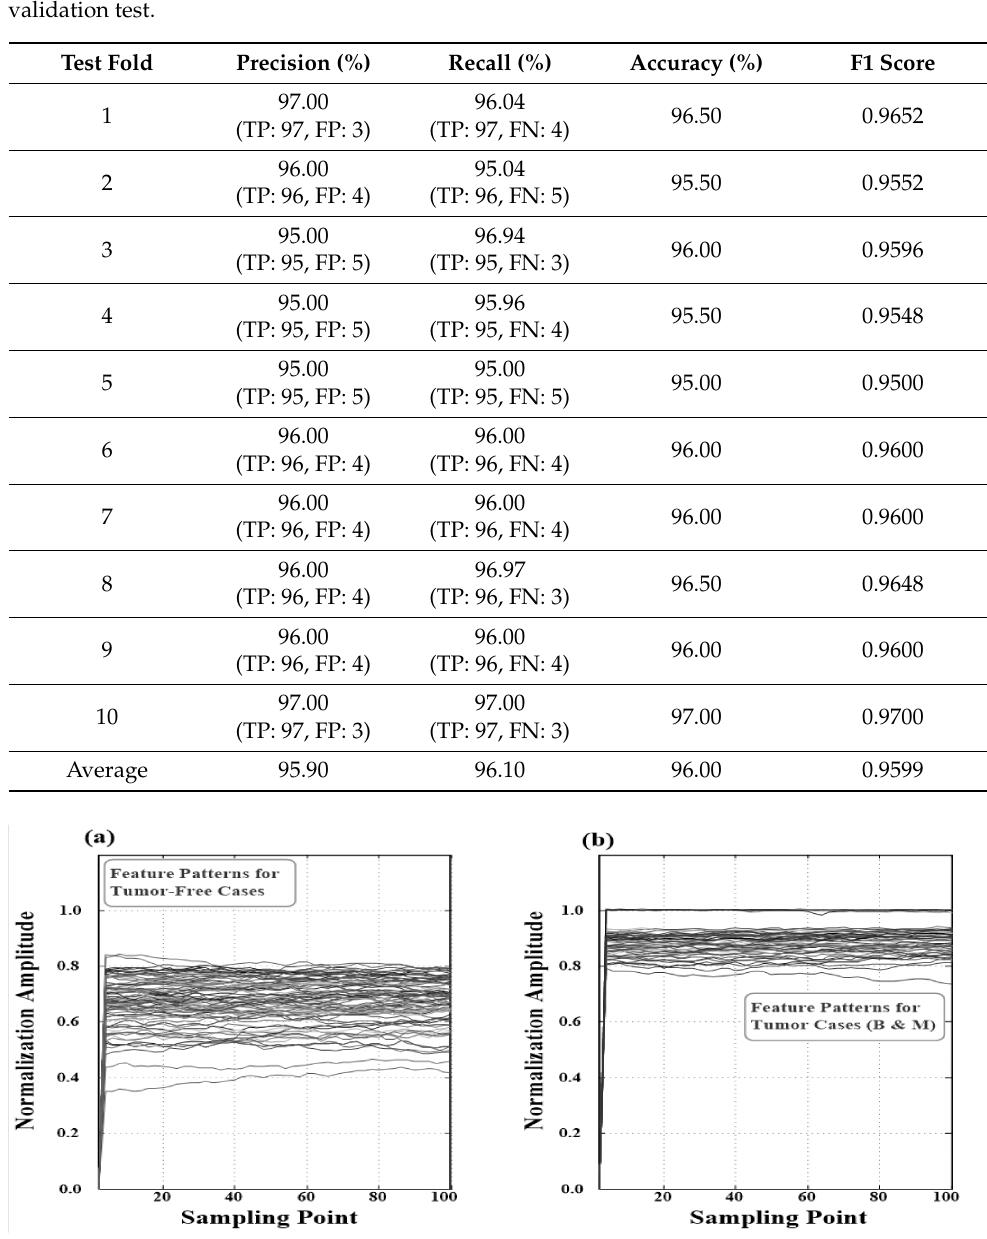
Figure 10. Feature signals for tumor-free and tumor cases. ( a ) Tumor-free cases (100 Nors); ( b ) Tumor cases (50 Bs and 50 Ms). Table 4. Experimental results for 2D spatial and 1D CNN-based classifier with the 10-fold cross- validation